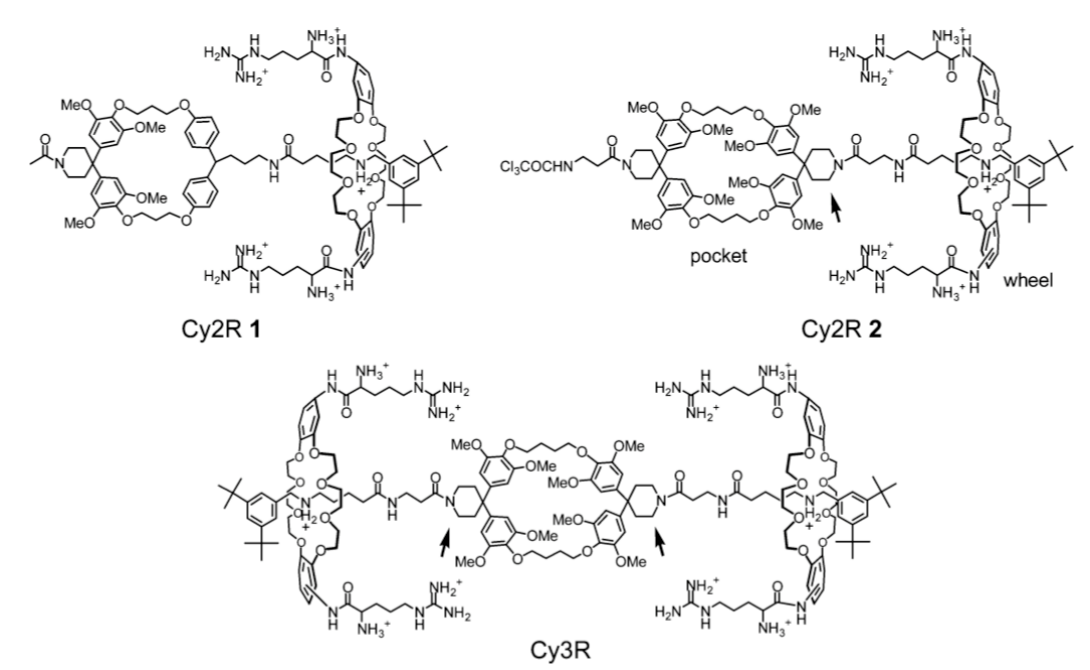
Figure 3. Examples of rotaxane bearing amino acids